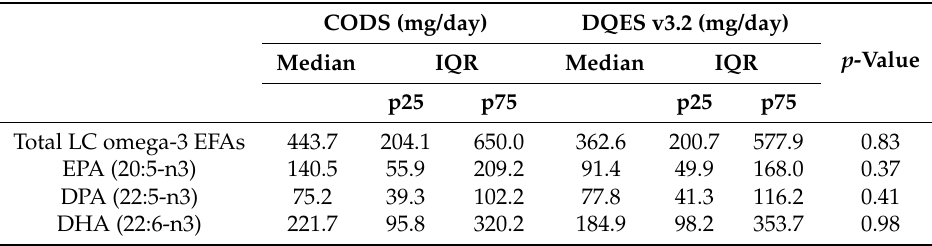
Table 1. Comparison of the median and inter-quartile range (IQR) values for long-chain omega-3 fatty acid intake, for the CODS and DQES v3.2 questionnaires, in the study cohort. CODS (mg/day)